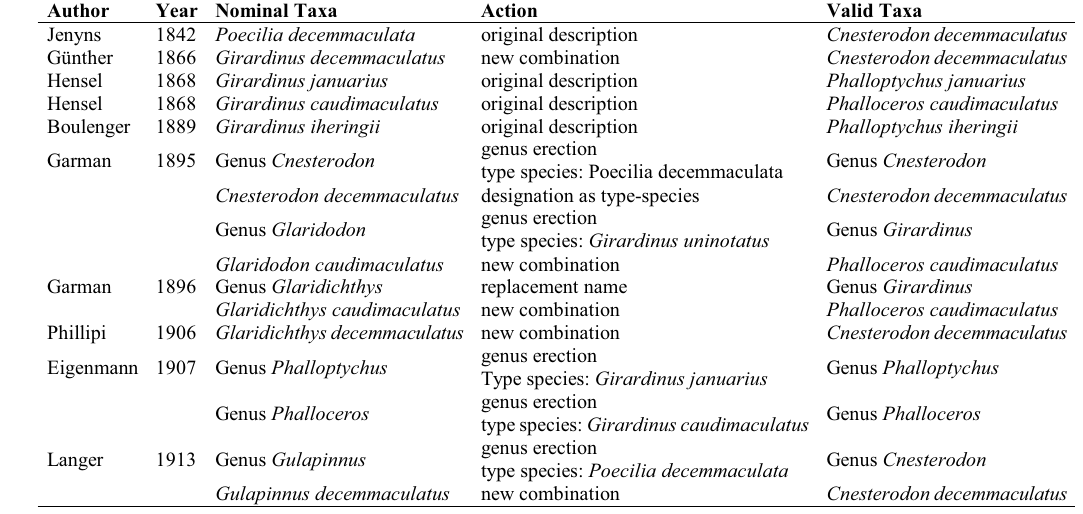
Table 1. Taxonomic history of the genus Cnesterodon , Phalloptychus and Phalloceros until